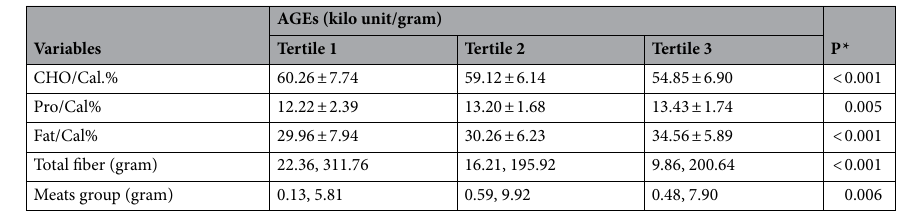
Table 3. Comparison of daily macronutrients intake/ calorie intake across AGEs tertiles. CHO Carbohydrate, Pro Protein. Comparison was done using One-Way ANOVA and Kruskal–Wallis. *P values based on ANCOVA adjusted for age and sex.